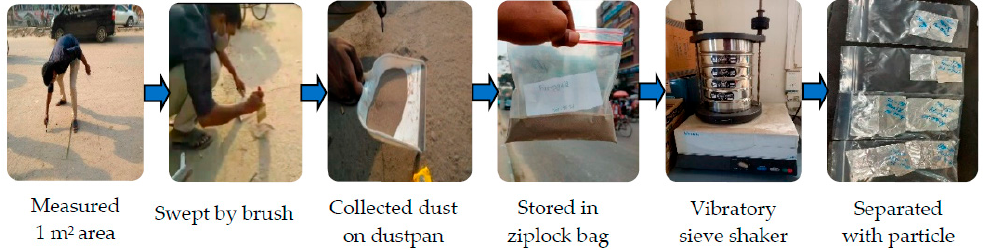
Figure 2. Collection and processing of street dust samples.